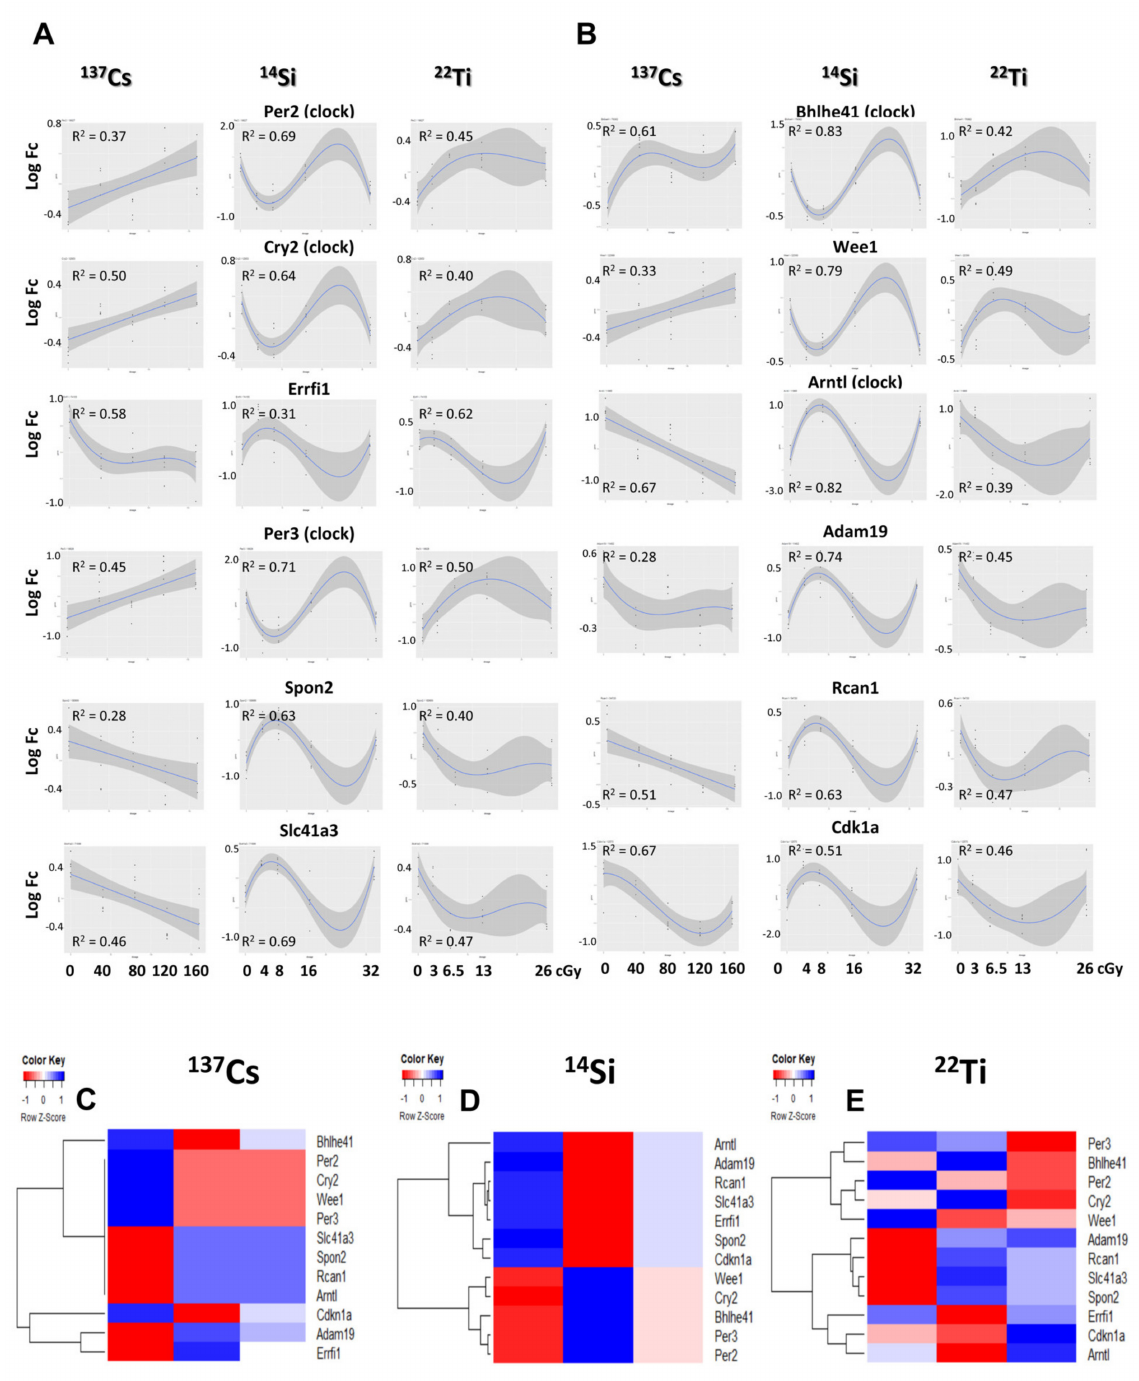
Figure 8. Dose–response analyses of expression of 12 genes commonly deregulated in all three radiation conditions: ( A , B ) expression profile–exposure dosage analysis indicates that 137 Cs irradiation mostly causes linear changes in gene expression, while irradiation with 14 Si and 22 Ti mainly induces a non-linear gene expression response. ( C – E ) Heatmap clustering of non-linear regression fit coefficients for 12 common genes in 137 Cs-, 14 Si-, and 22 Ti-IR groups, respectively. The columns in heatmaps represent non-linear fit